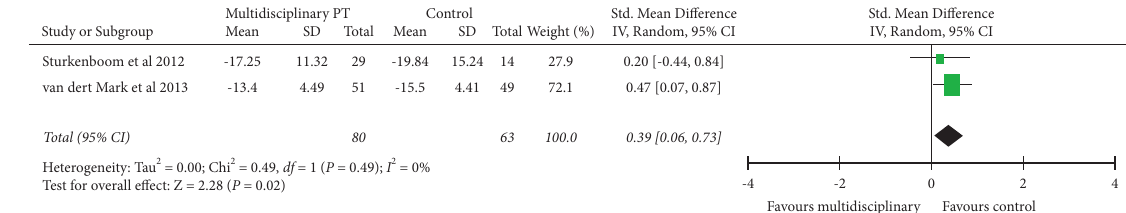
Figure 5: Forest plot multidisciplinary physiotherapy with the control group: anxiety